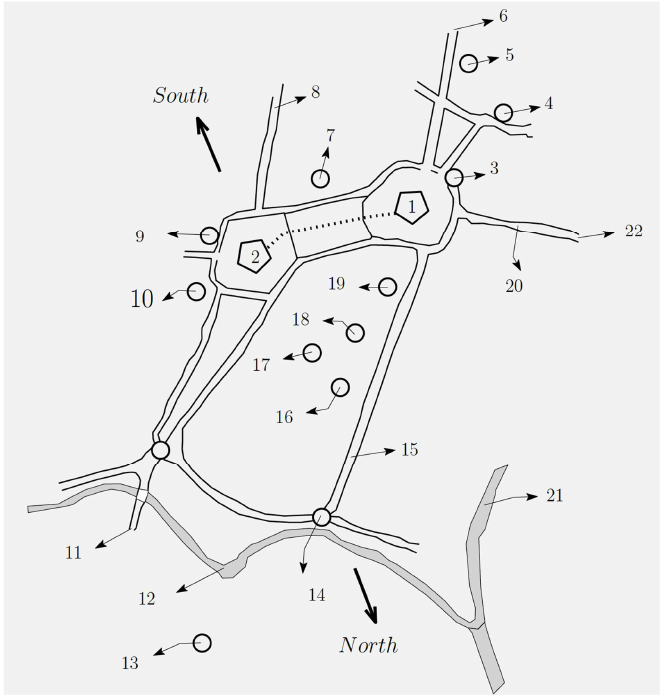
Figure 1. The Ashura Assemblage: Karbala’s Major and Minor Pilgrimage Spaces and Places. Source: Original source rendered from sketch provided by Muhammad-Reza Fakhr-Rohani, 2021.